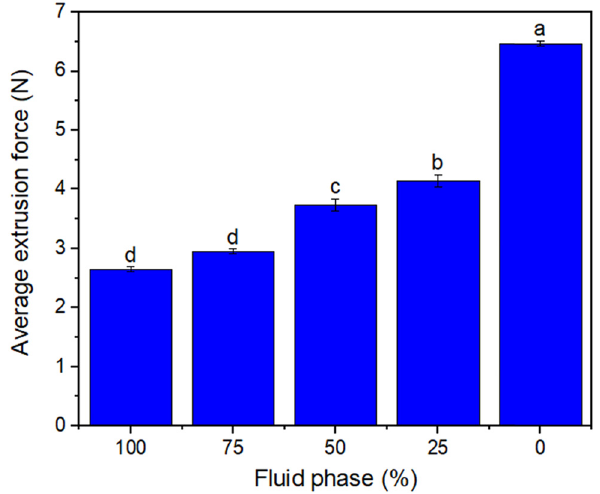
Figure 5: In fl uence of the fl uid phase fraction of HA on the extrusion force of the oxi - HA/ADH microcarriers. Data are reported as mean ± SD for experiments in triplicate. Mean values with the same letter indicate that there is no signi fi cant di ff erence ( p < 0.05 ) by the Tukey